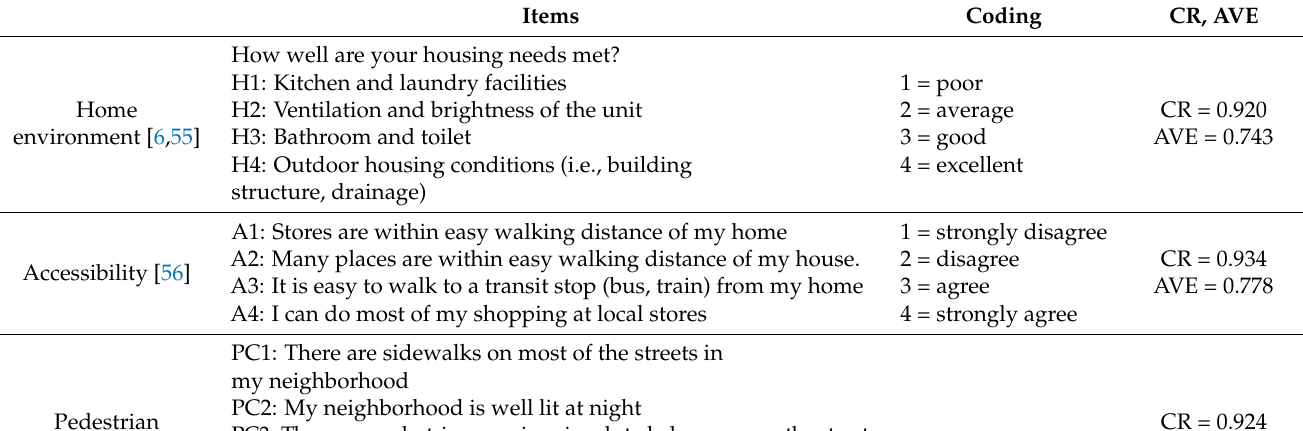
Table 1. Measures of surveyed variables. Items Coding CR,